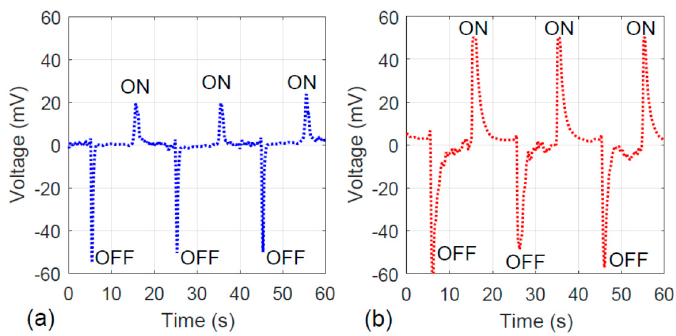
Figure 10. Photovoltaic responses of the specimens: ( a ) without hydrothermal carbonization treatment and ( b ) with hydrothermal carbonization treatment.